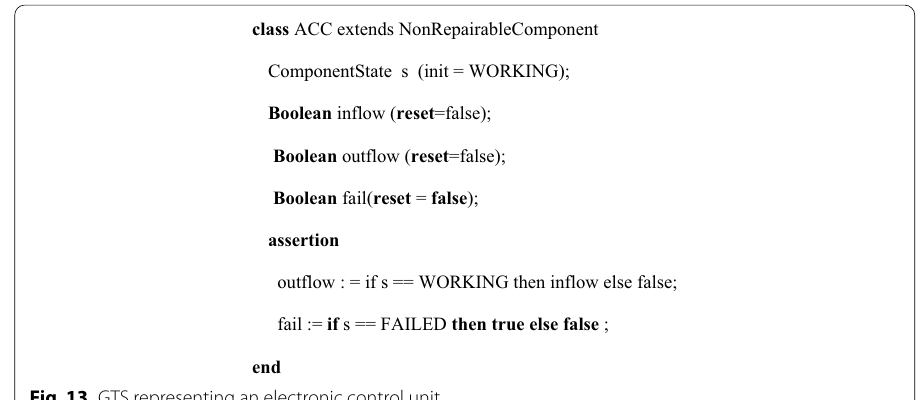
Fig. 13 GTS representing an electronic control